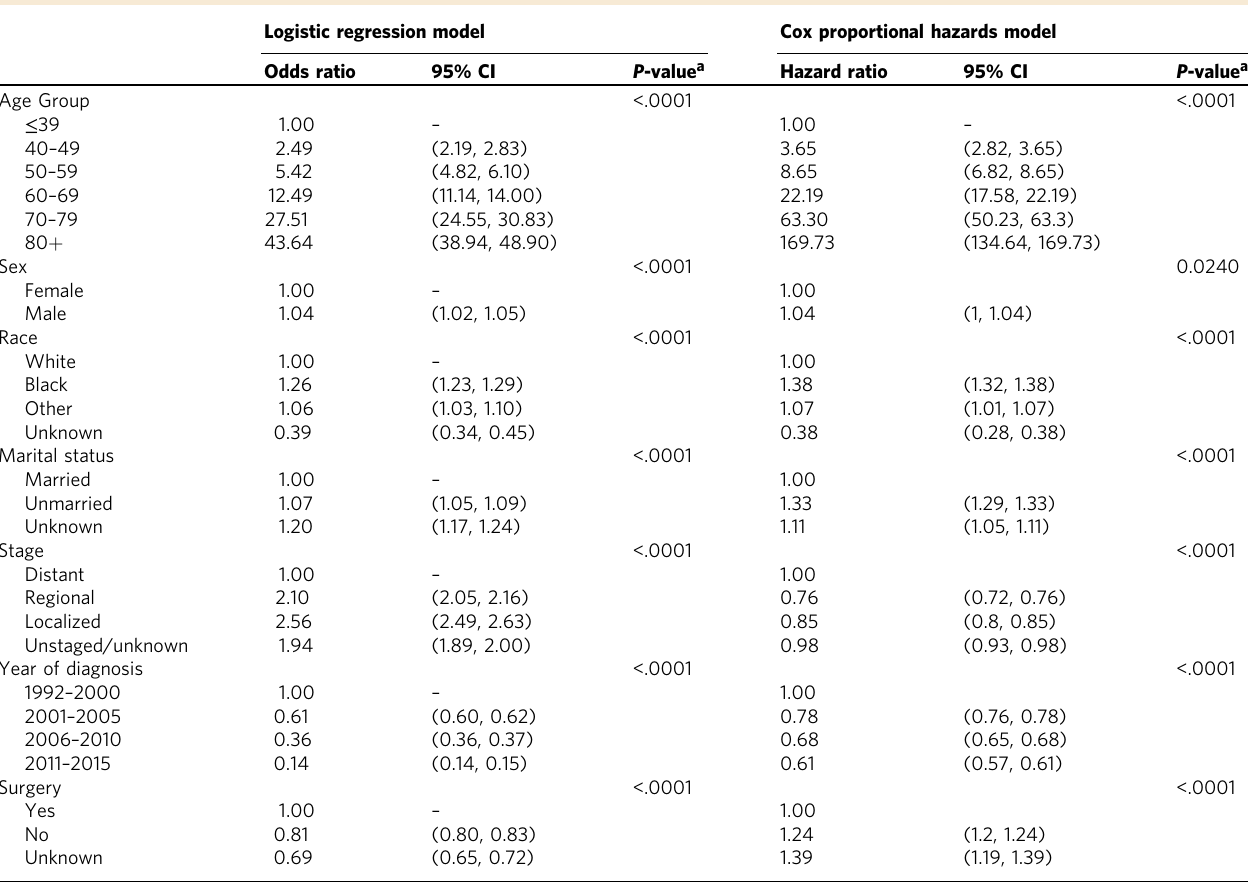
Table 2 Odds ratios and hazard ratios of stroke among cancer patients Logistic regression